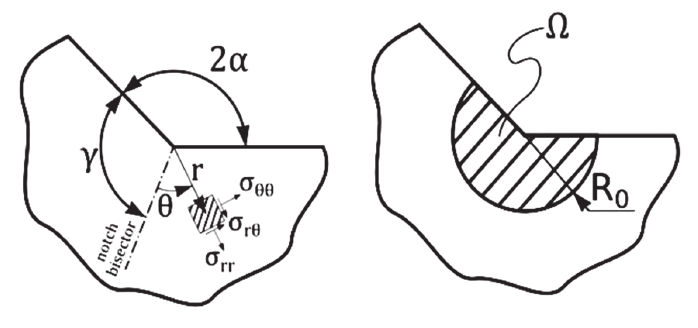
Figure 1: Polar coordinate system centred at the notch